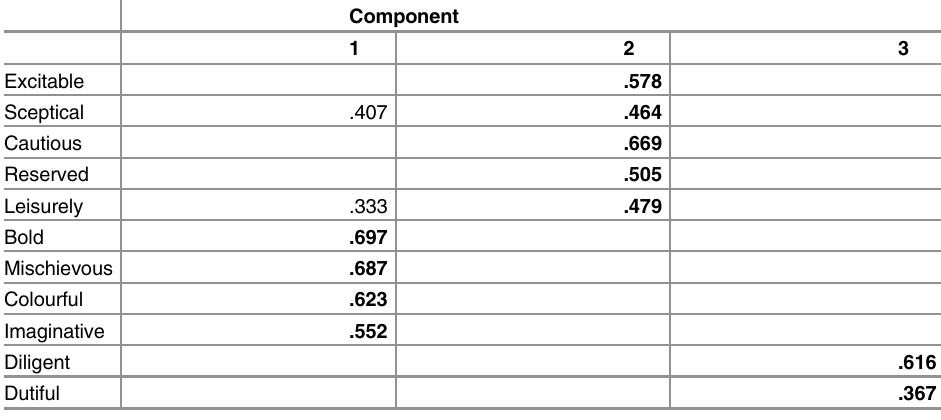
Table 2. Principle Axis Factoring (with Varimax rotation) of the 11 HDS